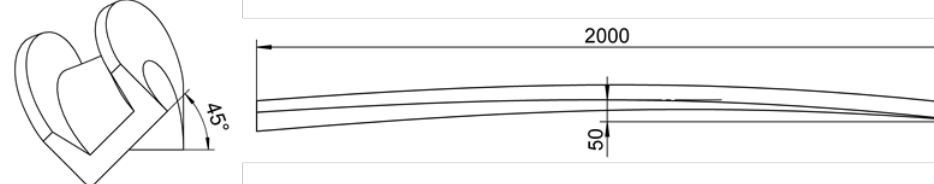
Figure 11. The geometric model of the initial shape of the profile.